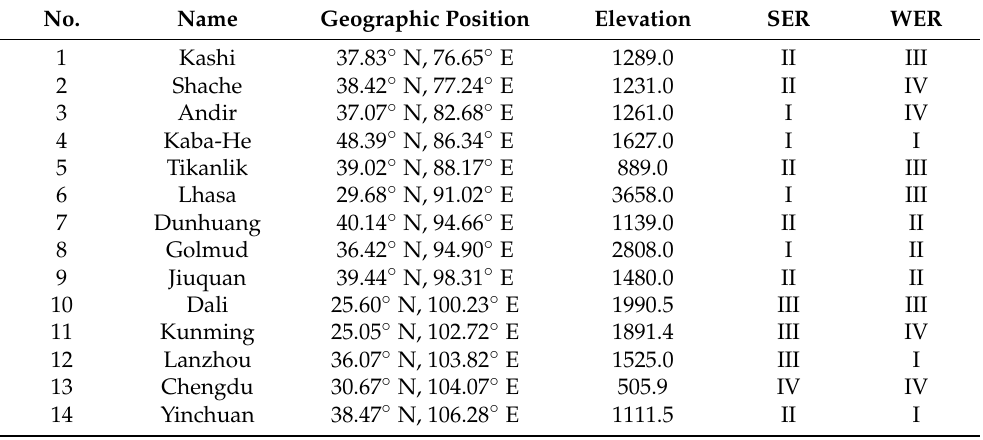
Table 5. Geographic conditions and natural resources classification of 26 regions in